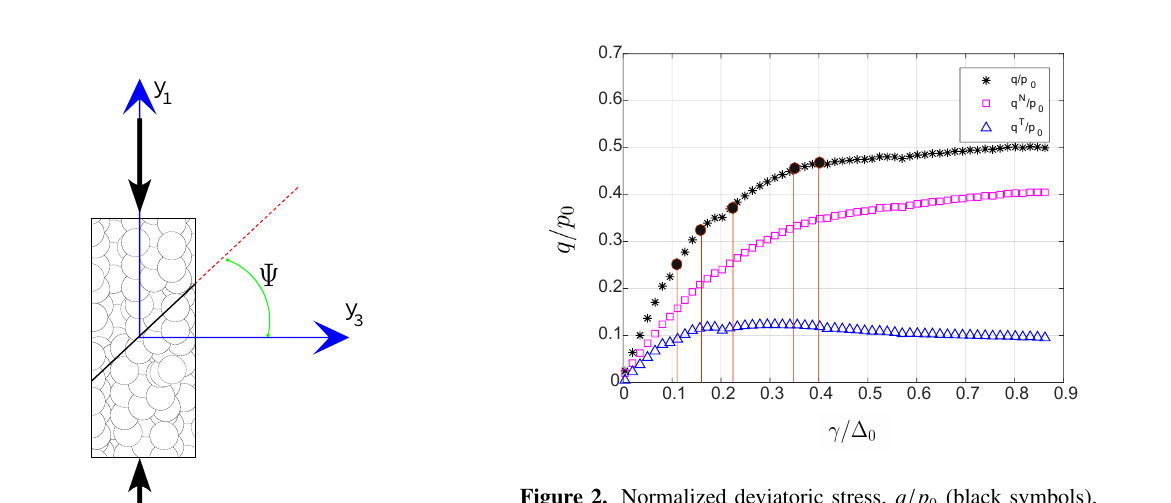
Figure 2. Normalized deviatoric stress, q / p 0 (black symbols), versus normalized deviatoric strain, γ/ p 0 , and its components q N / p 0 (magenta symbols) and q T / p 0 (blue